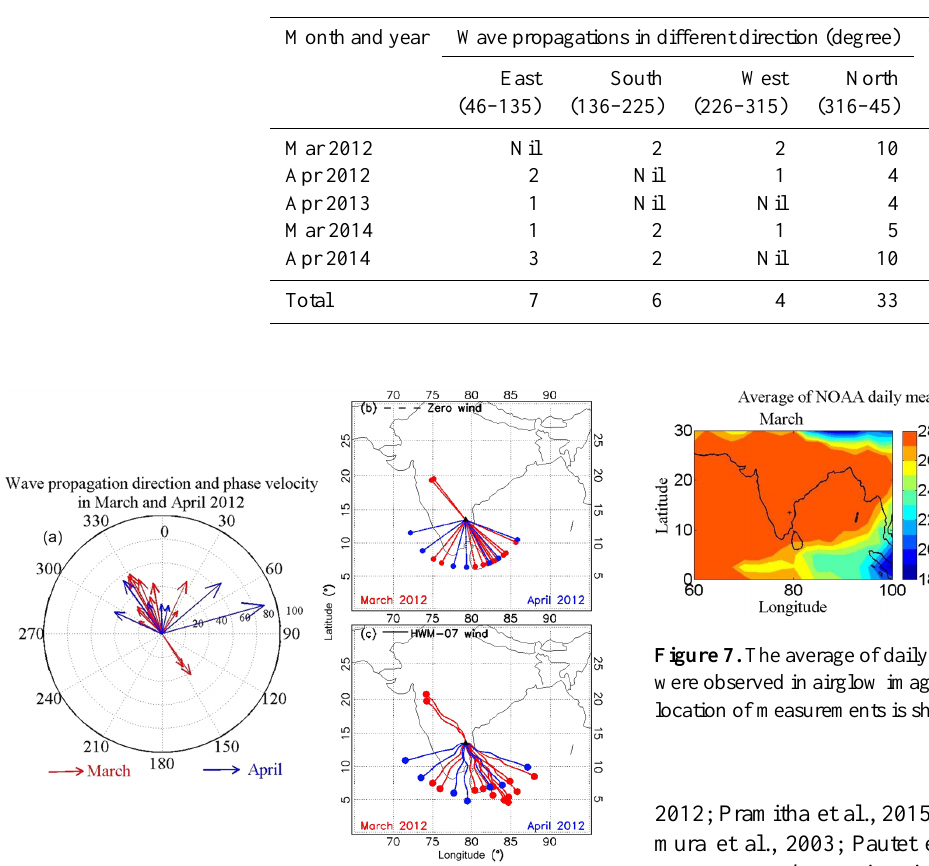
Table 1. Predominant wave propagation directions during different months.